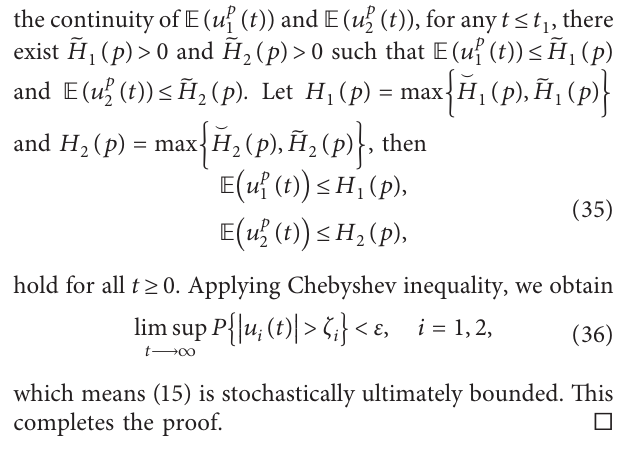
( 0 ) � x ( 0 ) � 2. (a) The time series graph of x 1 2 � 0 ; σ ( t ) � 0 ; i � 1 , 2), (d) the phase graph of impulsive system ik i